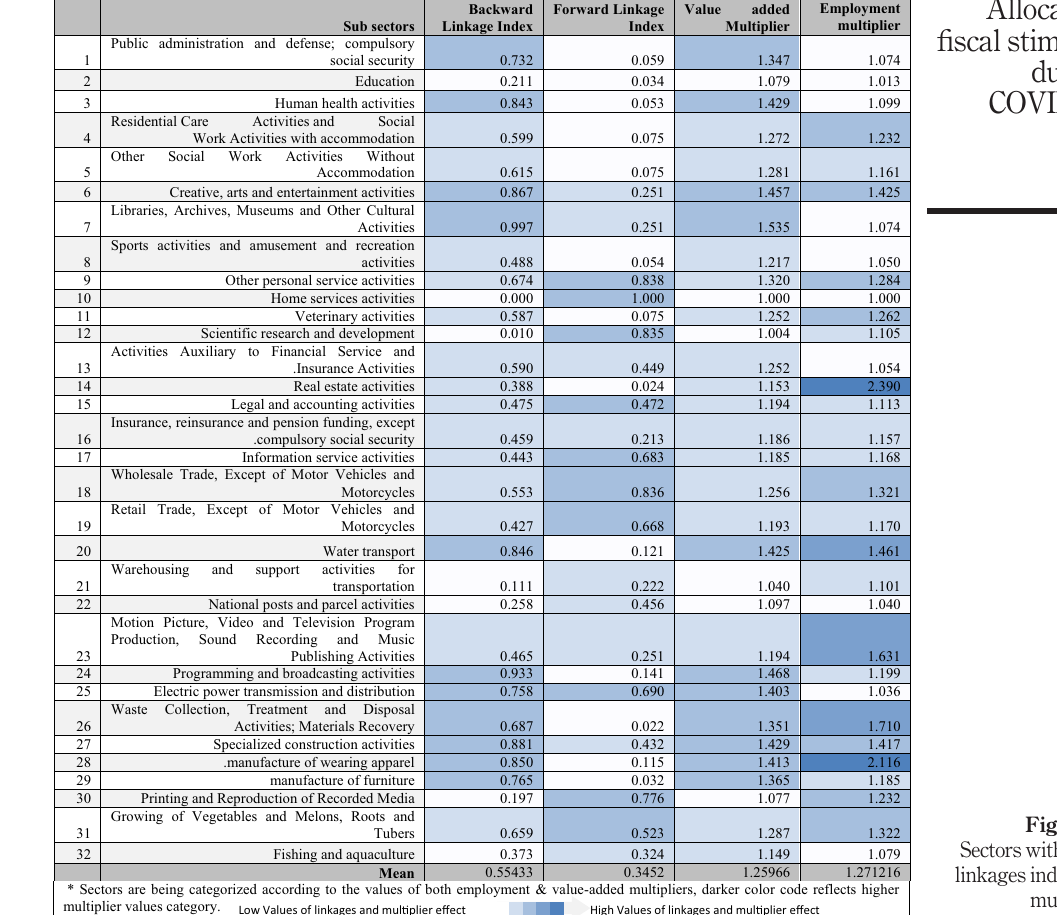
Figure 4. Sectors with weak linkages index and